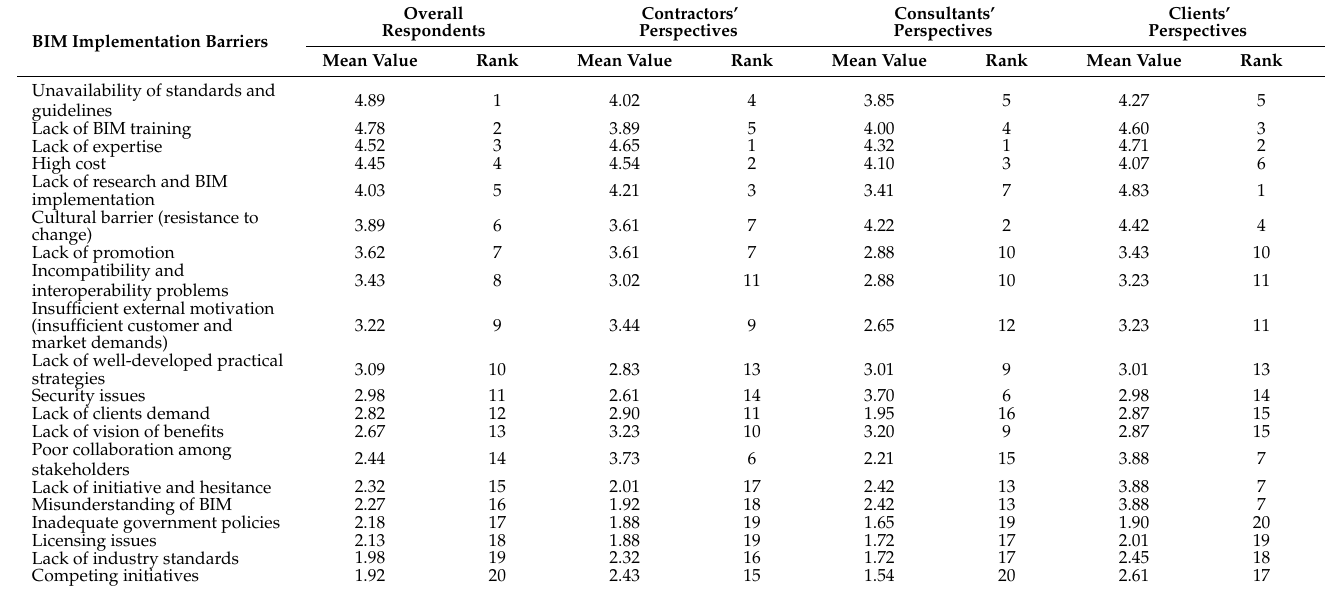
Table 4. Ranking of BIM implementation